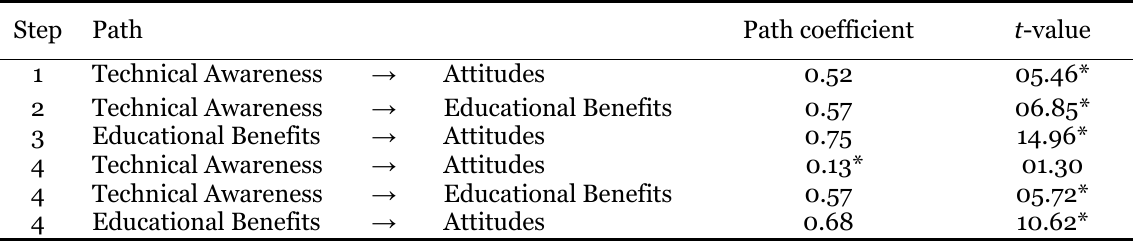
Parent Results for Technical Awareness, Educational Benefits, and Attitudes